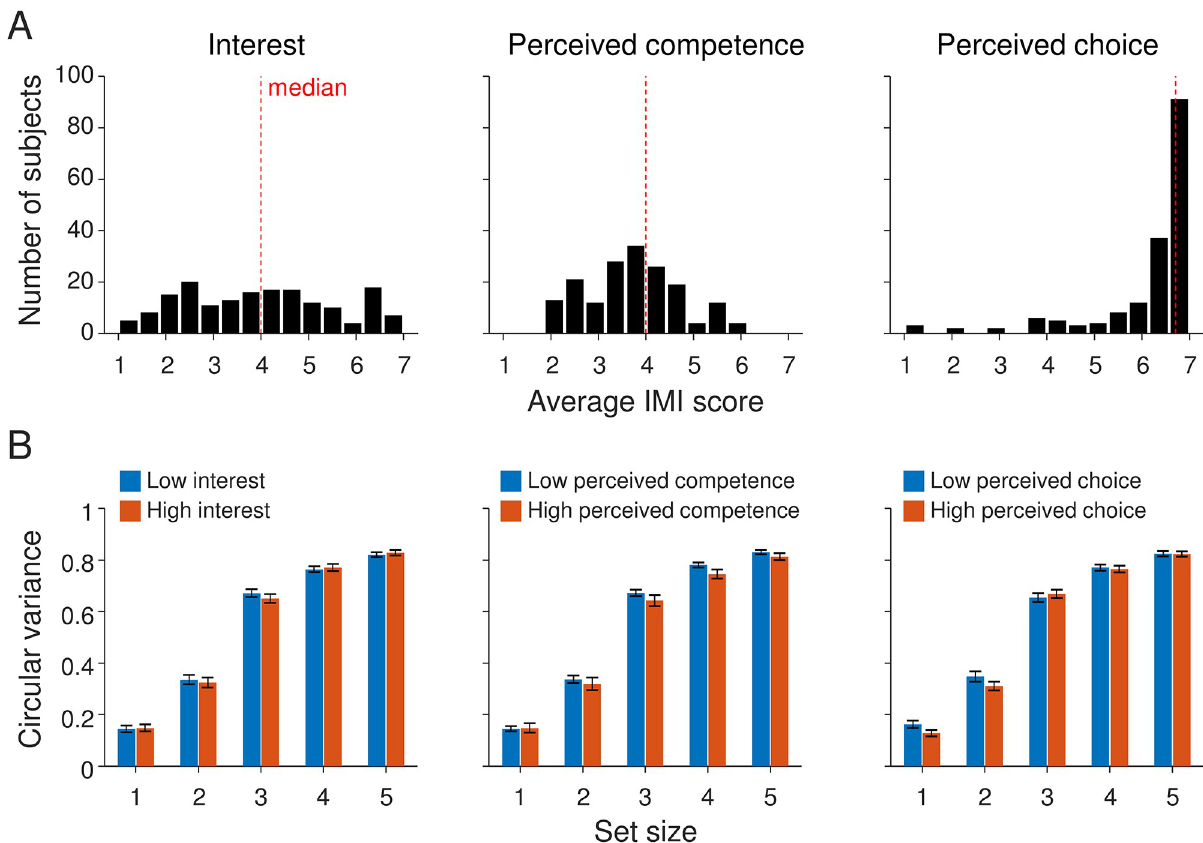
Fig 3. Comparison of VWM performance between subjects with low and high scores on the Intrinsic Motivation Inventory (IMI). (A) Distribution of average IMI scores, split by question category. (B) Circular variance of the response error plotted separately for subjects with below-median and above-median scores on the IMI